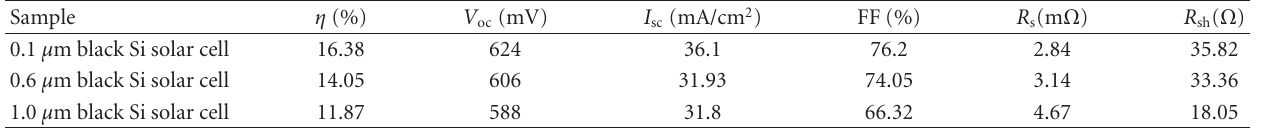
Figure 4: 6 (cid:2)(cid:2) mc-Si photovoltaic (PV) solar cells textured with average (a) 100 nm-thick and (b) 1 μ m-thick nanorods. The feature di ff erence is remarkable for the two solar cells. The 1 μ m-thick nanorods generate the dark black color easily recognized by the naked eye and the grain boundaries also become nondistinguishable compared with the solar cell with surface textured using 100 nm-thick nanorods. Table 2: I - V characteristic of black Si solar